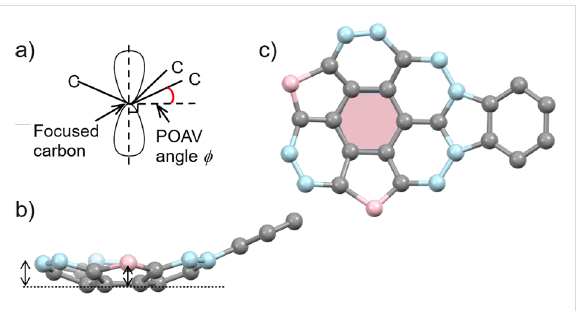
Figure 3: a) Definition of POAV angle ( φ ). b) Side and c) top view of the molecular skeleton of 1 . The double-headed arrow show the